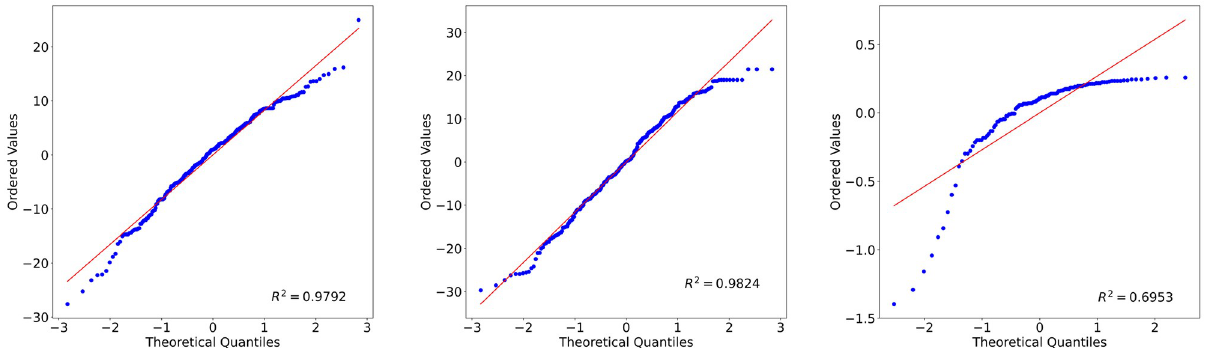
Fig 6. Probability plots for Phase 2 data. (A)Emotion (B)Rater gender (C)Speaker gender data.